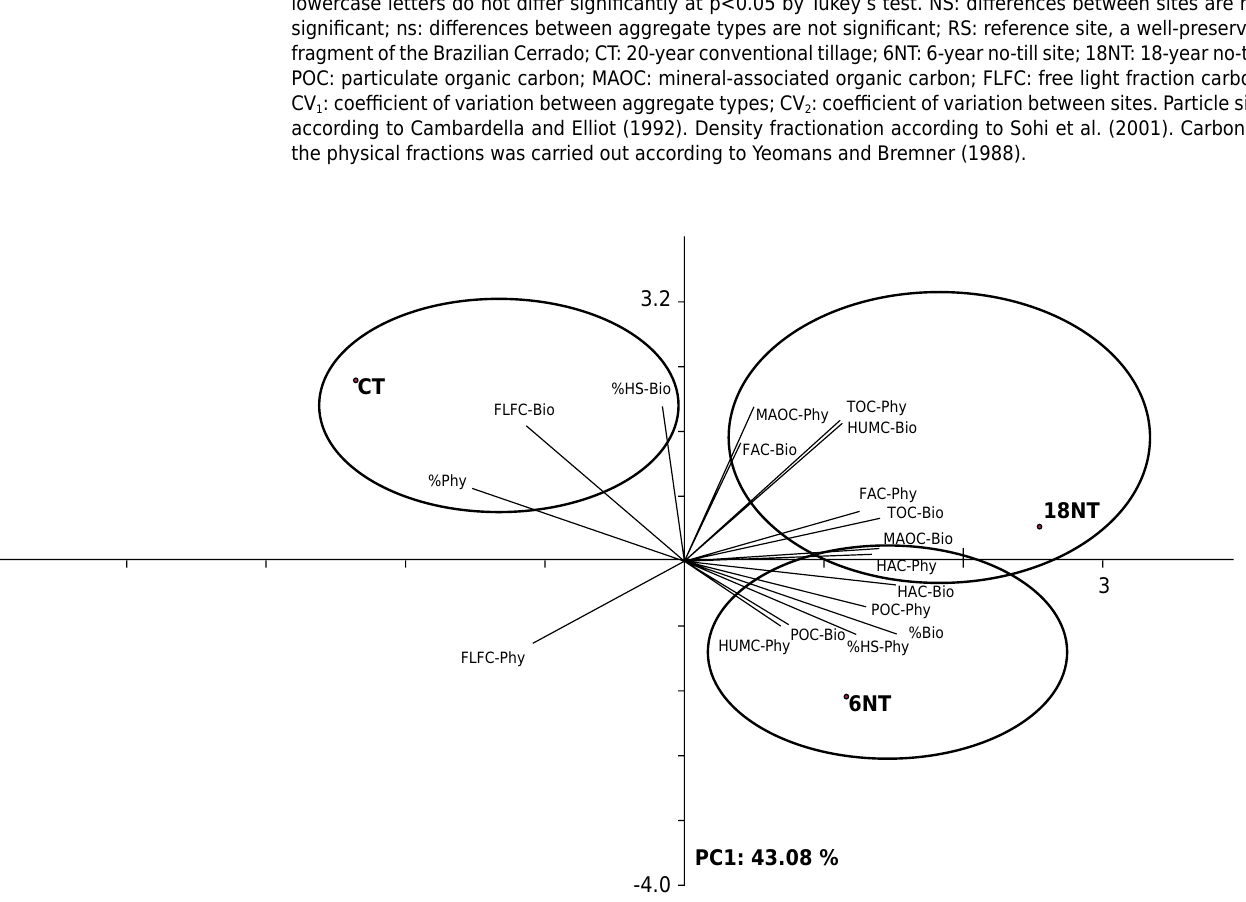
Figure 6. Principal component analysis of total organic carbon and chemical and physical fractions of soil organic matter in physicogenic (Phy) and biogenic (Bio) aggregates from 0.00-0.05 m soil layer under different management systems in the Cerrado region of Uberaba, Minas Gerais, Brazil. CT: 20-year conventional tillage; 6NT: 6-year no-till; 18NT: 18-year no-till; TOC: total organic carbon; FAC: fulvic acid carbon; HAC: humic acid carbon; HUMC: humin carbon; %HS: percentage of humic substances; POC: particulate organic